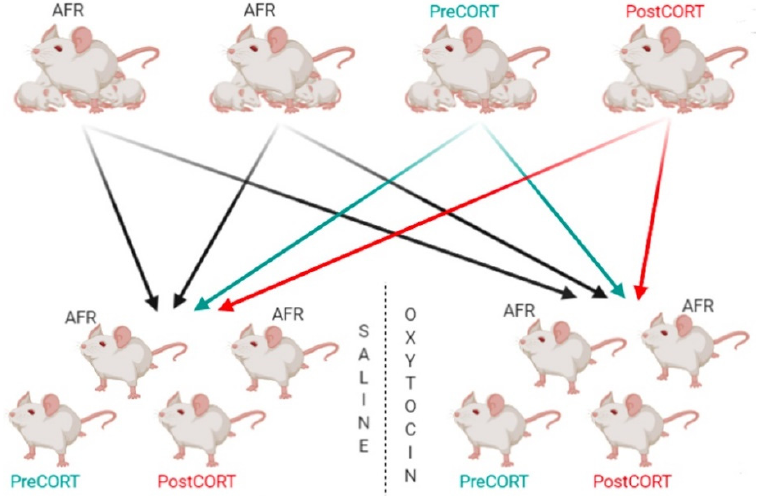
Figure 18. Rearrangements at weaning. Schematic illustration of family rearrangements at weaning, for arm 1. Male subjects were rearranged in order to obtain pairs of identical 4-mice groups, randomly assigned either to SAL Lane or OXT Lane. Each group consisted of 2 AFR, 1 PreCORT and 1 PostCORT subjects .